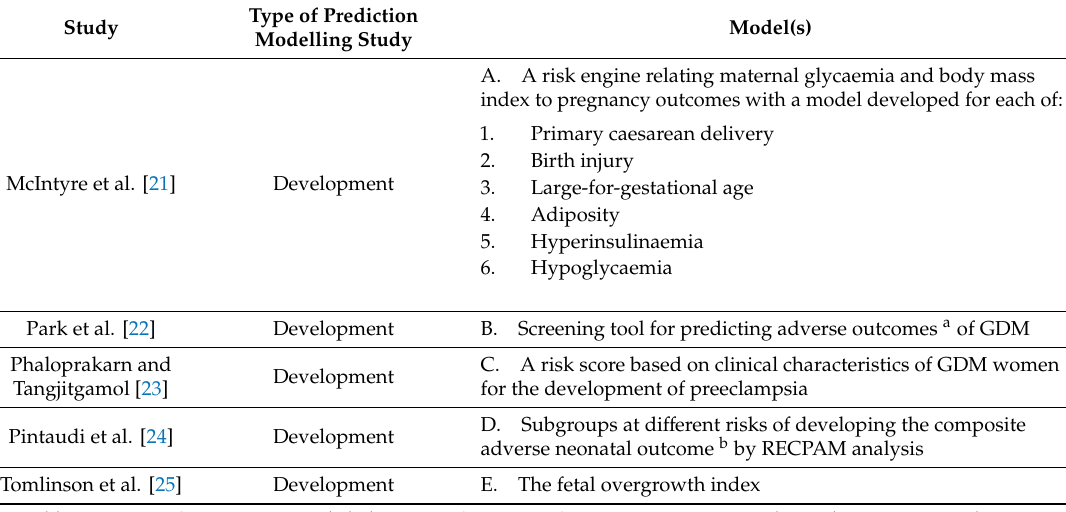
Table 1. The ten models developed by the five prediction modelling studies for pregnancy complications in women with gestational